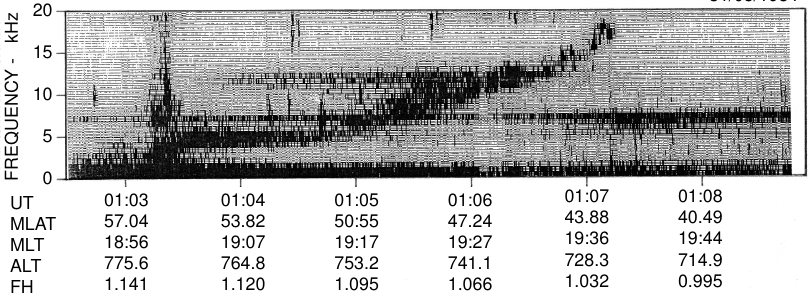
Figure 2 Morioka et al. Fig. 2. Expanded dynamic spectrum of LHR band emissions observed on 31 May 1984.